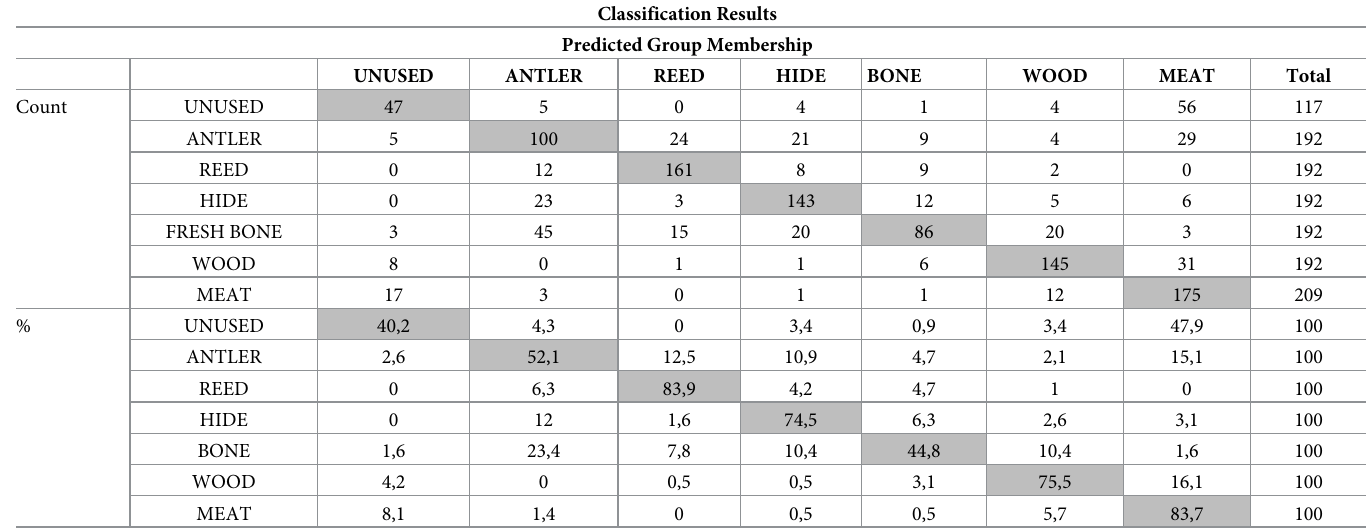
Table 2. Results of classification of the six worked materials (antler, reed, hide, bone, wood and meat) and no use by quadratic discriminant analysis. 66.6% of origi- nal grouped cases were correctly classified. Shaded cells correspond to correct classifications.